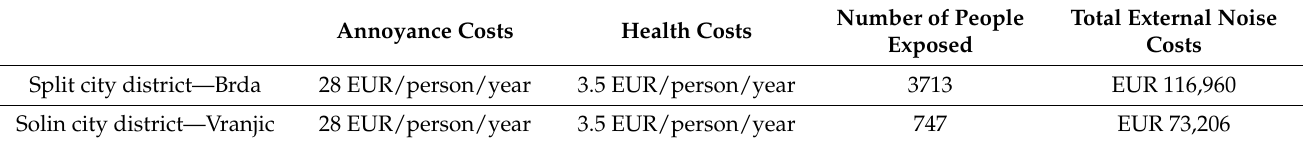
Table 8. Total external noise costs in the port of Split (yearly